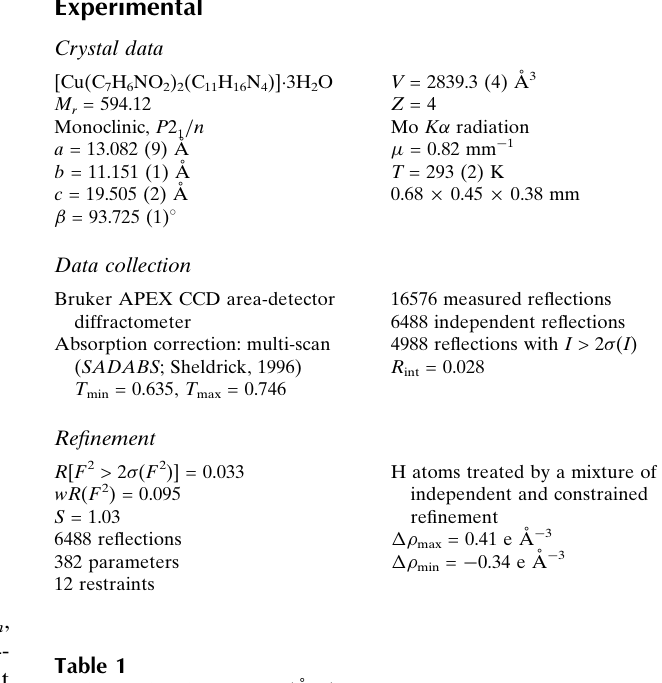
Hydrogen-bond geometry (A˚ , (cid:2)